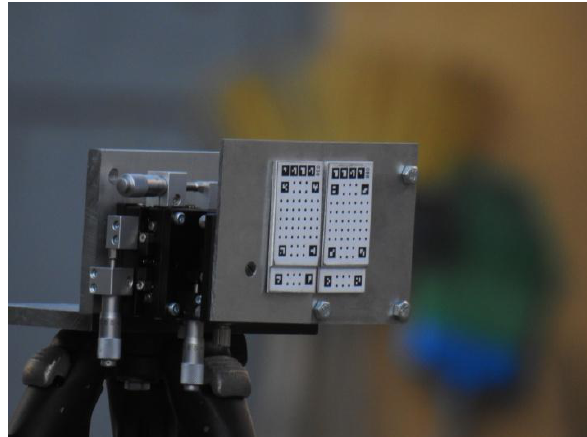
Figure 12. Three-axis micrometer with mounted marker of the crack measurer